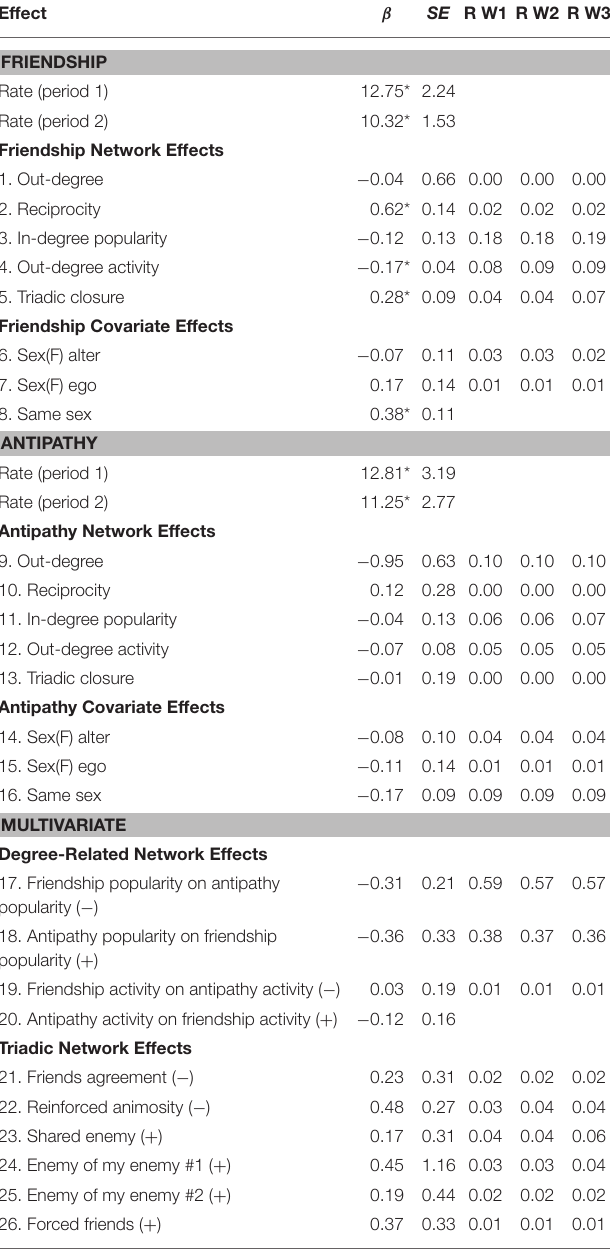
TABLE 5 | Multivariate model: parameter estimates ( β ), standard errors ( SE ) and expected relevance importance for each wave (R W).